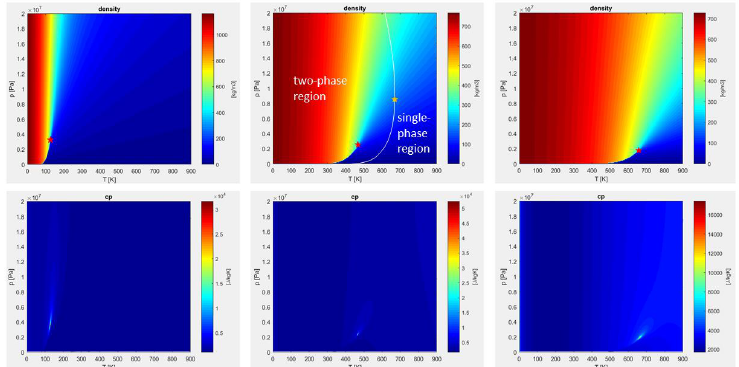
Figure 1. Pressure-temperature plots of density and specific heat at constant pressure, for pure nitrogen ( left ), nitrogen/n-dodecane mixture—50% by volume ( middle ), pure n-dodecane ( right ), calculated with Peng-Robinson equation of state (PR-EOS). Red stars identify the pure and pseudo-fluid critical points. Yellow star identifies the real mixture critical point, evaluated by means of the NIST database [54].